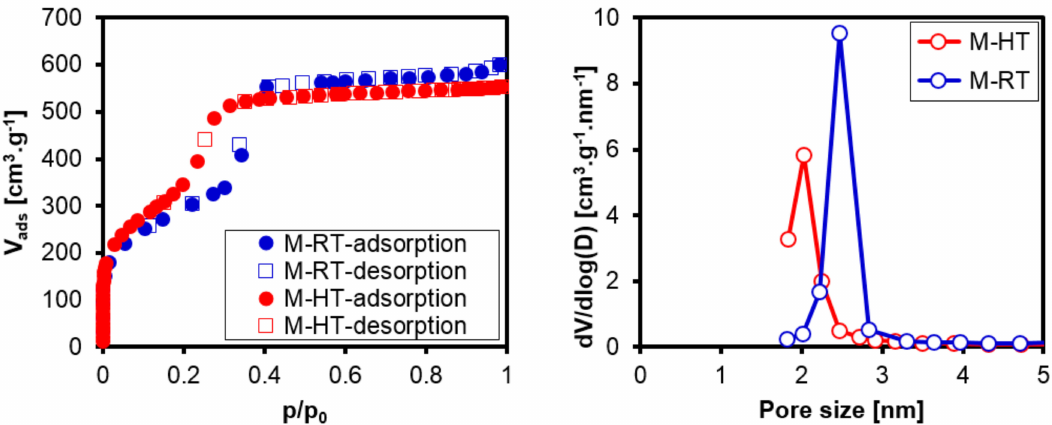
Figure 6. ( a ) Nitrogen adsorption and desorption isotherms (obtained at 77 K) for the calcined silicas; ( b ) the pore diameter distribution obtained using the BJH method.